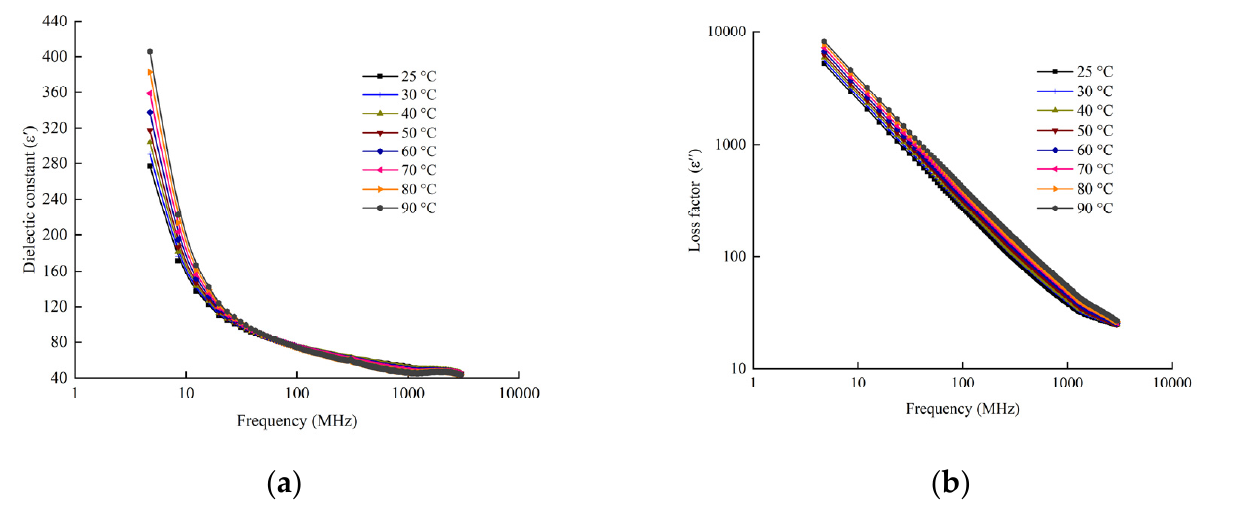
Figure 4. DPs related with frequency of beef sausage at different temperatures (25, 30, 40, 50, 60, 70, 80 and 90 °C), ( a ) dielectric constant ( ε′ ) as dependent variable, ( b ) dielectric loss factor ( ε ″ ) as dependent variable.